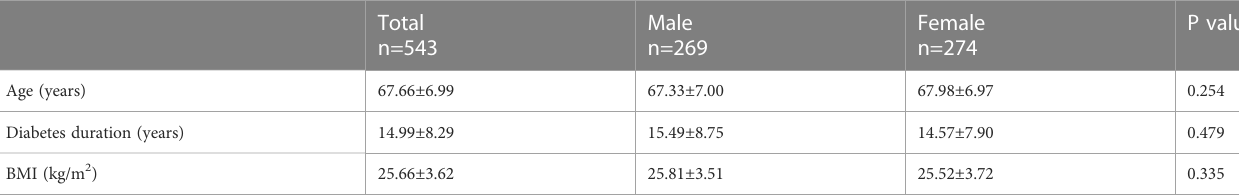
TABLE 1 The demographic characteristics of the participants by sexes.